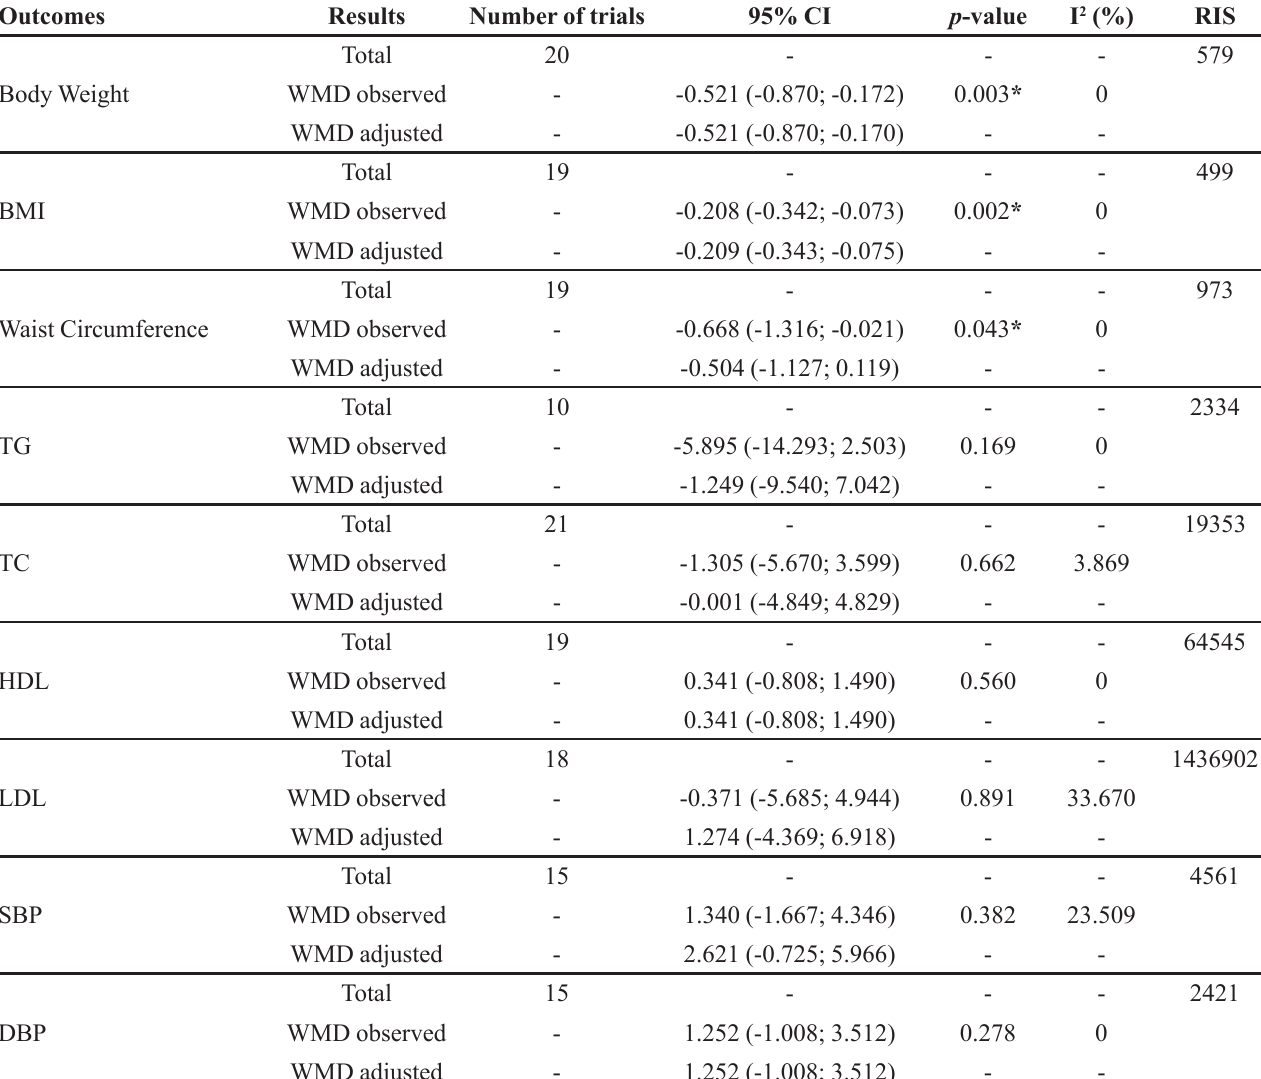
TABLE II - Meta-analysis results of the effects of I. paraguariensis consumption on the considered outcomes